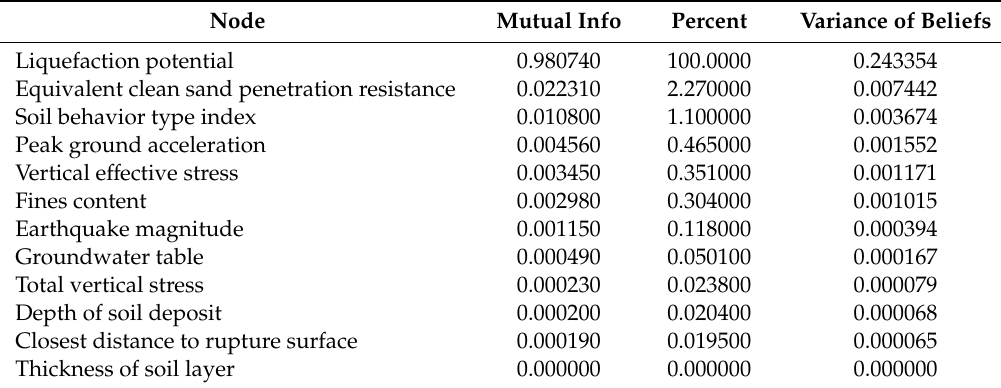
Table 7. Sensitivity analysis of “liquefaction